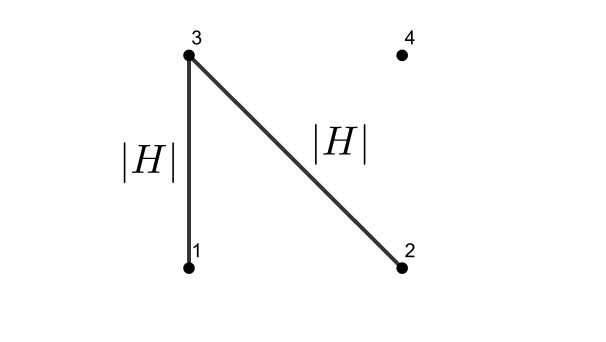
Figure 2. Example 2.